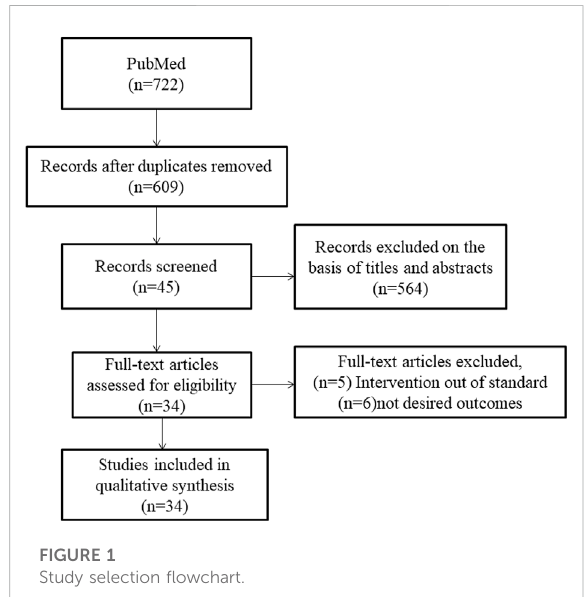
FIGURE 1 Study selection fl